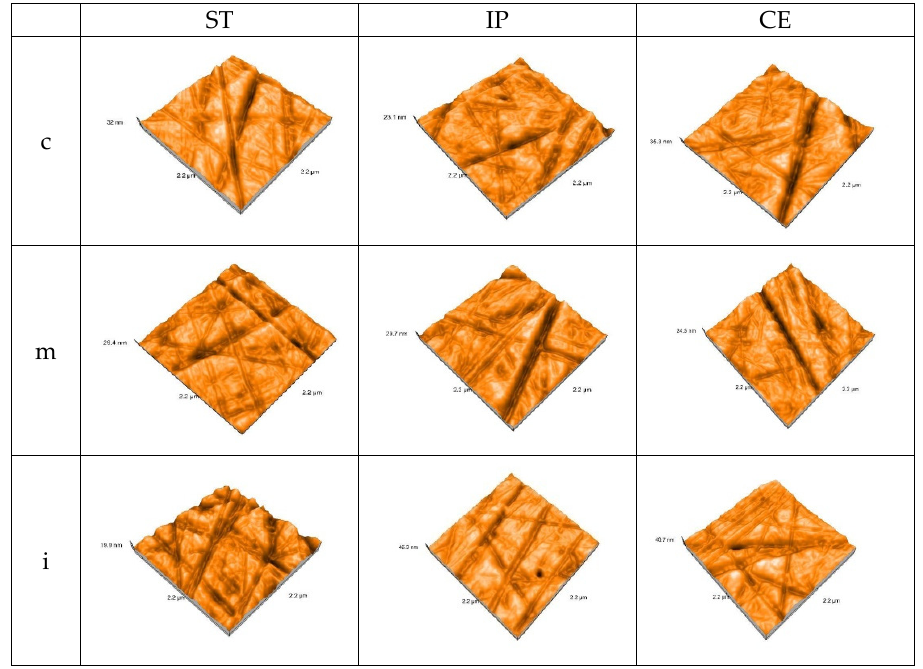
Figure 3. 3D AFM images of the glazed samples, before aging.ST = STML, IP = IPS e.maxZirCAD CEREC/in Lab MT Multi, CE = CeramillZolidfx ML. c = cervical, m = medium, i = incisal. The AFM 3D images on each area of the polished samples of the control group are shown in Figure 4.